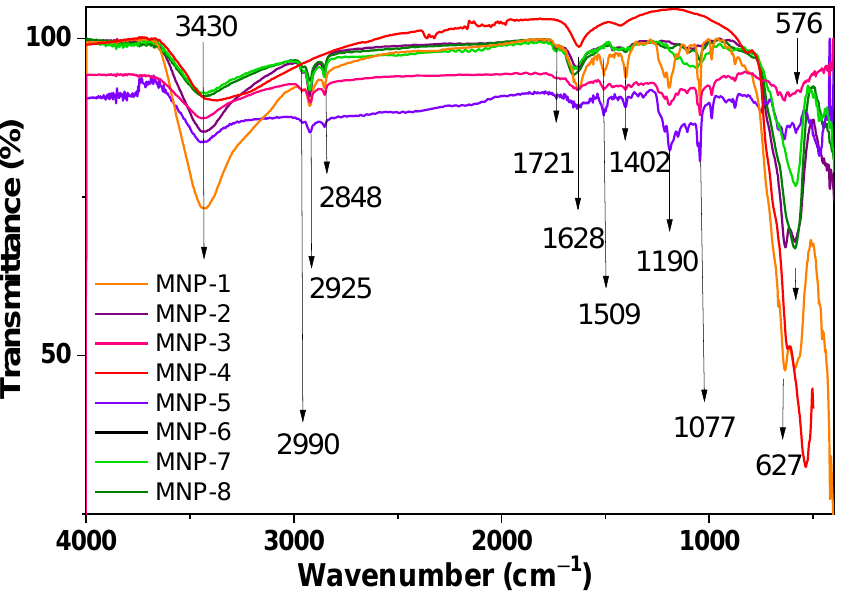
Figure 7. FTIR spectra of various as-prepared MNPs.